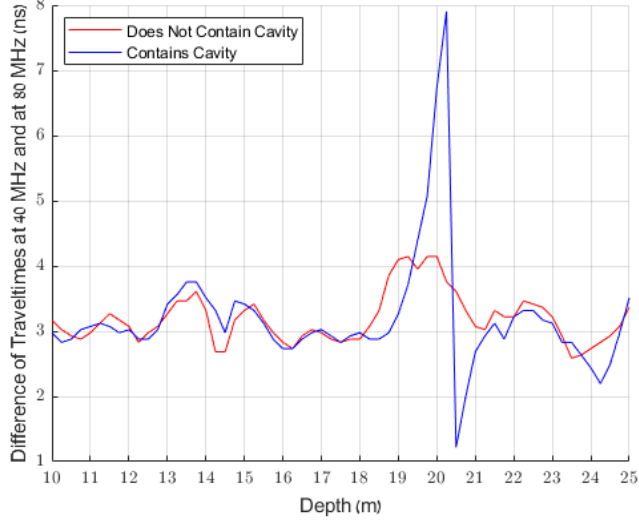
Figure 7. The difference in traveltime between the component of the signal centered at 40 MHz and the component of the signal centered at 80 MHz, drawn for every depth of the two real measured profiles shown in Figure